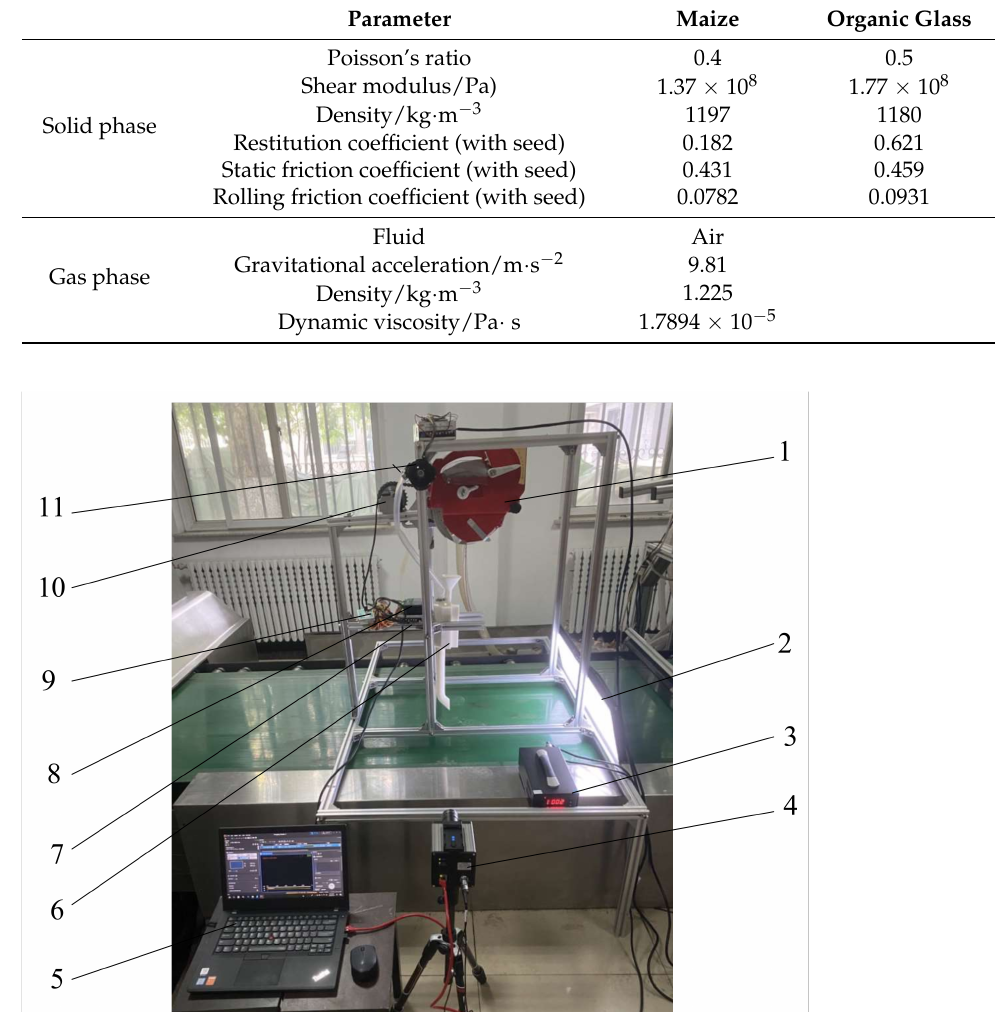
Table 1. Computational parameters used in the simulation.